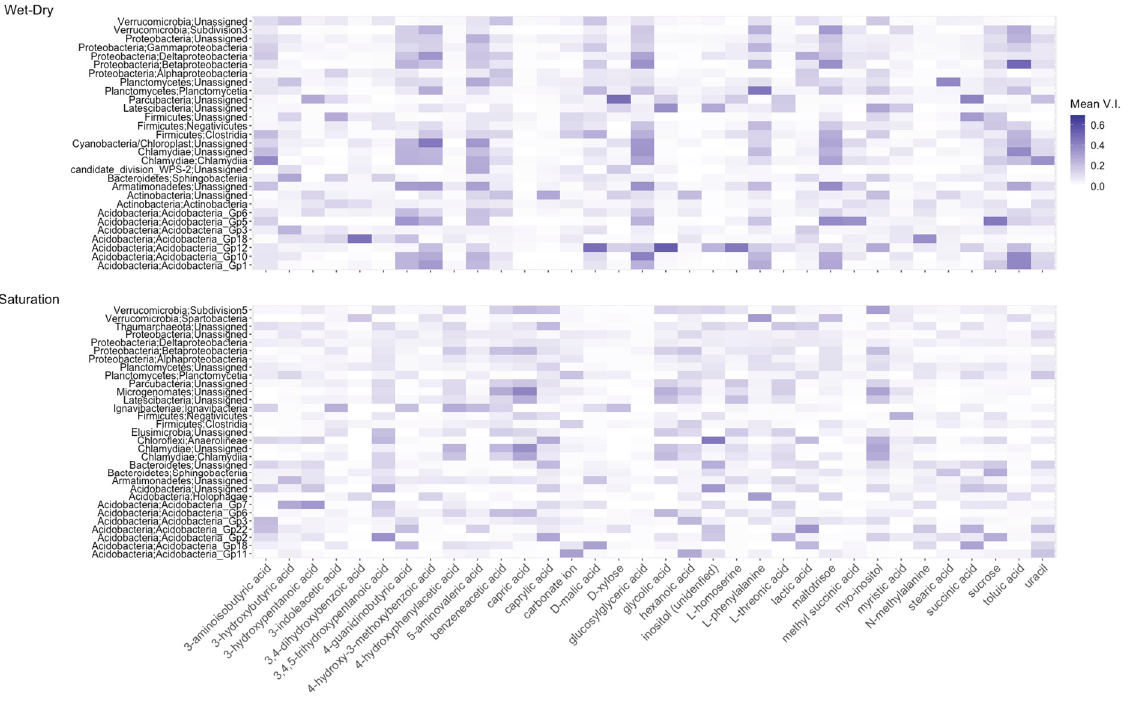
Figure 3. Metabolites ranked based on their mean variable importance for predicting OTUs under Wet-Dry ( top ) and Saturation ( bottom ) treatments.